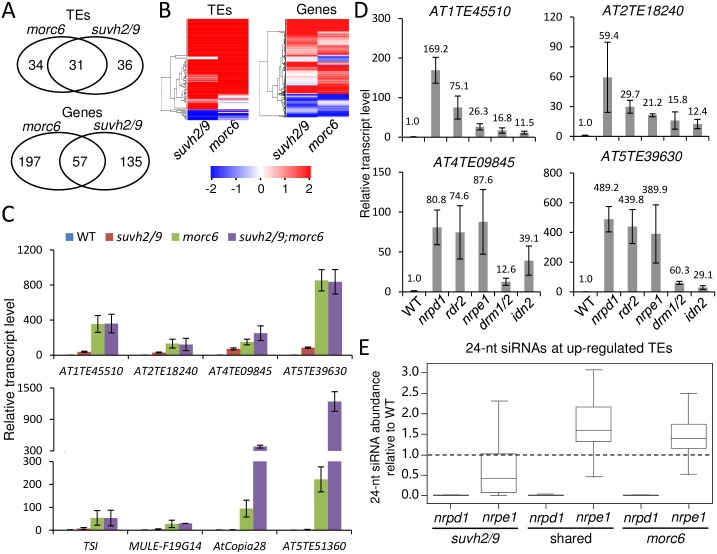
Identification and characterization of target loci shared by SUVH2/9 and MORC6.(A) Venn diagrams of overlap between up-regulated (2-fold increase; p<0.01 by Cufflinks) TEs and genes in morc6 and suvh2/9. (B) Heat maps of differentially expressed TEs and genes in suvh2/9 and morc6 relative to the wild type. Up- and down-regulated loci are shown by red and blue lines, respectively. Color scales represent log2 (mutant/WT). (C) The RNA transcript levels of MORC6 target loci were determined by quantitative RT-PCR in the wild type, suvh2/9, morc6, and suvh2/9;morc6. ACT2 was used as an internal control. Error bars are standard deviation of three biological replicates. (D) Effect of the RdDM mutations nrpd1, rdr2, nrpe1, drm1/2, and idn2 on the transcript levels of SUVH2/9 and MORC6 common target TEs as determined by quantitative RT-PCR analysis. Error bars are standard deviation of three biological replicates. (E) The effect of nrpd1 and nrpe1 on the abundance of 24-nt siRNAs at SUVH2/9 and MORC6 target TEs. Based on small RNA deep sequencing data, the 24-nt siRNA abundance in nrpd1 and nrpe1 is compared with that in the wild type and fold changes are indicated by y-axis.